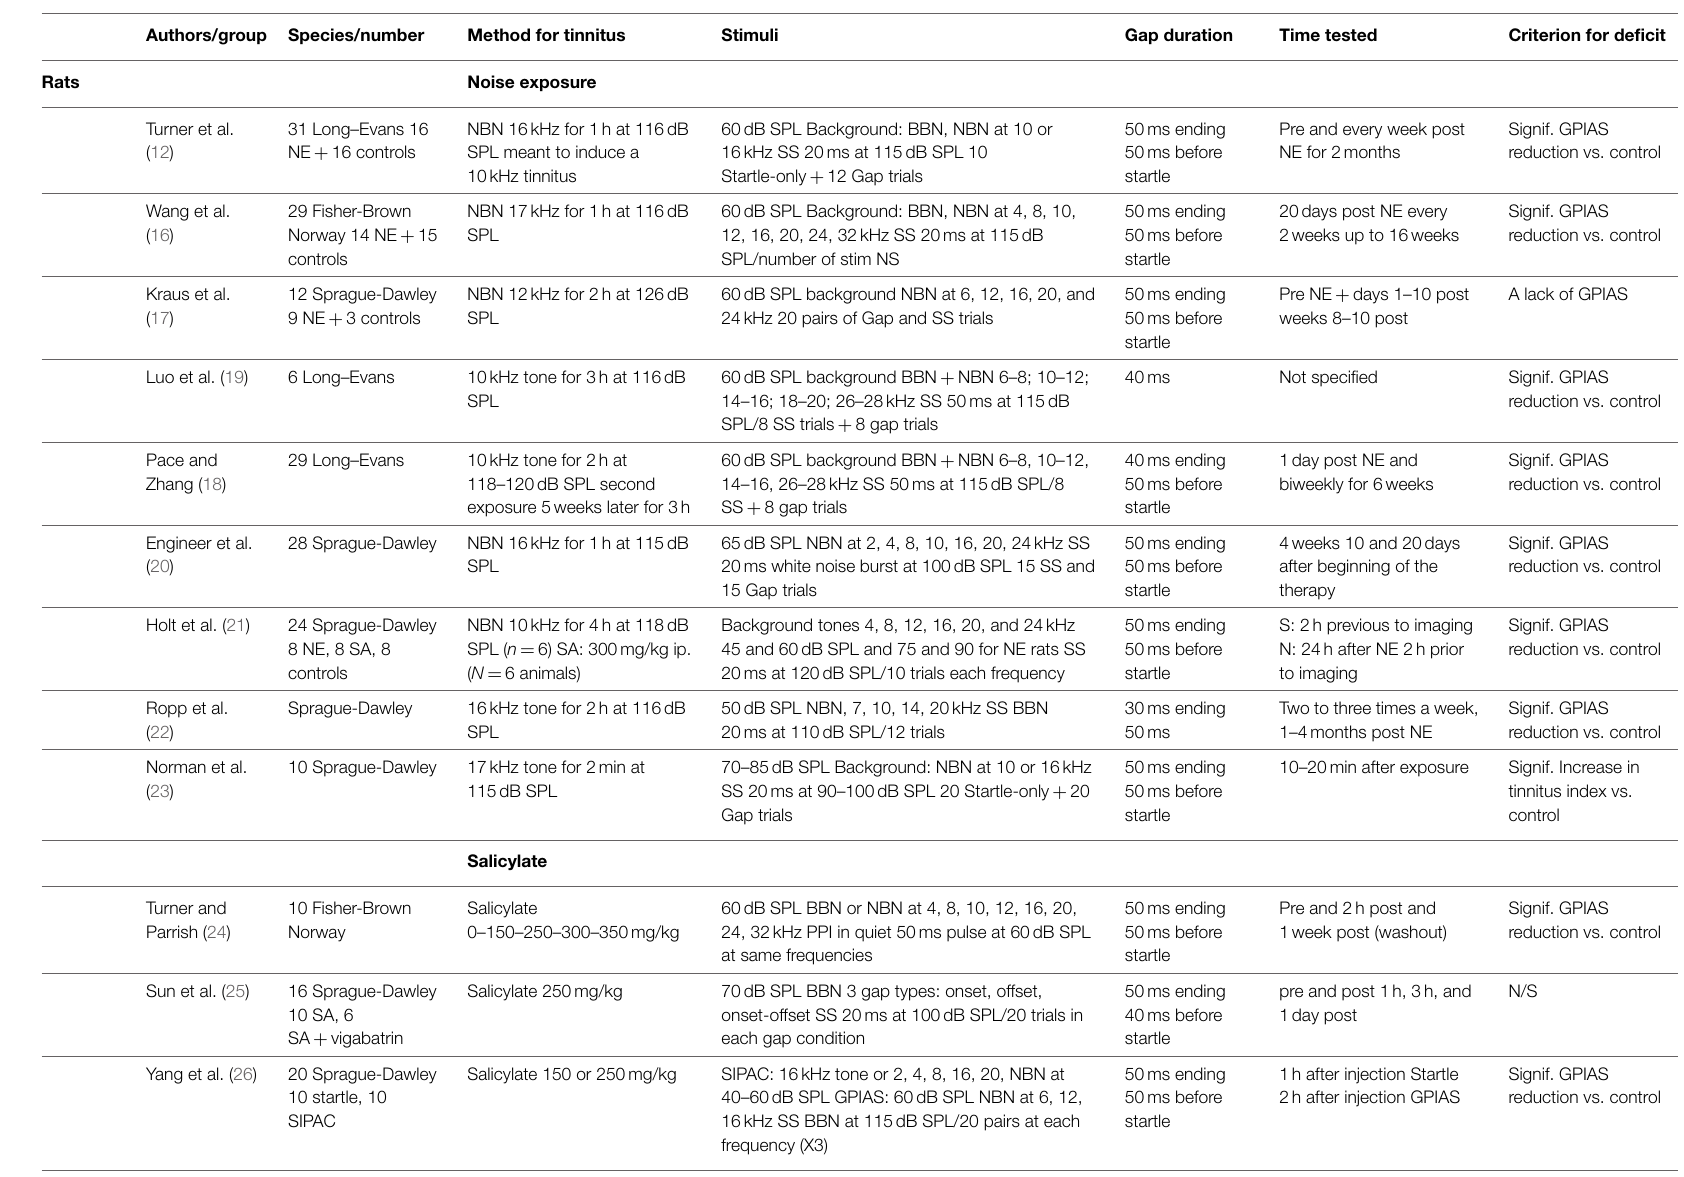
TABLE 1 | Main methodological characteristics of animal studies that have used GPIAS and human studies that have examined gap detection for tinnitus assessment . Authors/group Species/number Method for tinnitus Stimuli Gap duration Time tested Criterion for deficit